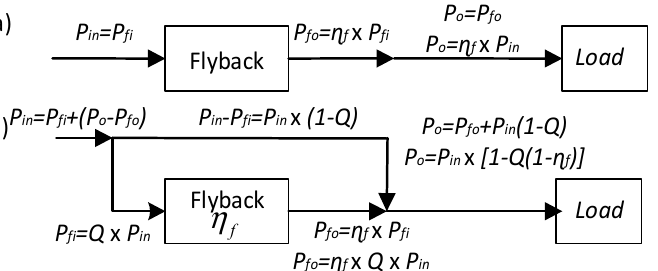
Figure 4. Power flow diagrams of the conventional flyback converter (a) and the proposed circuit (b).